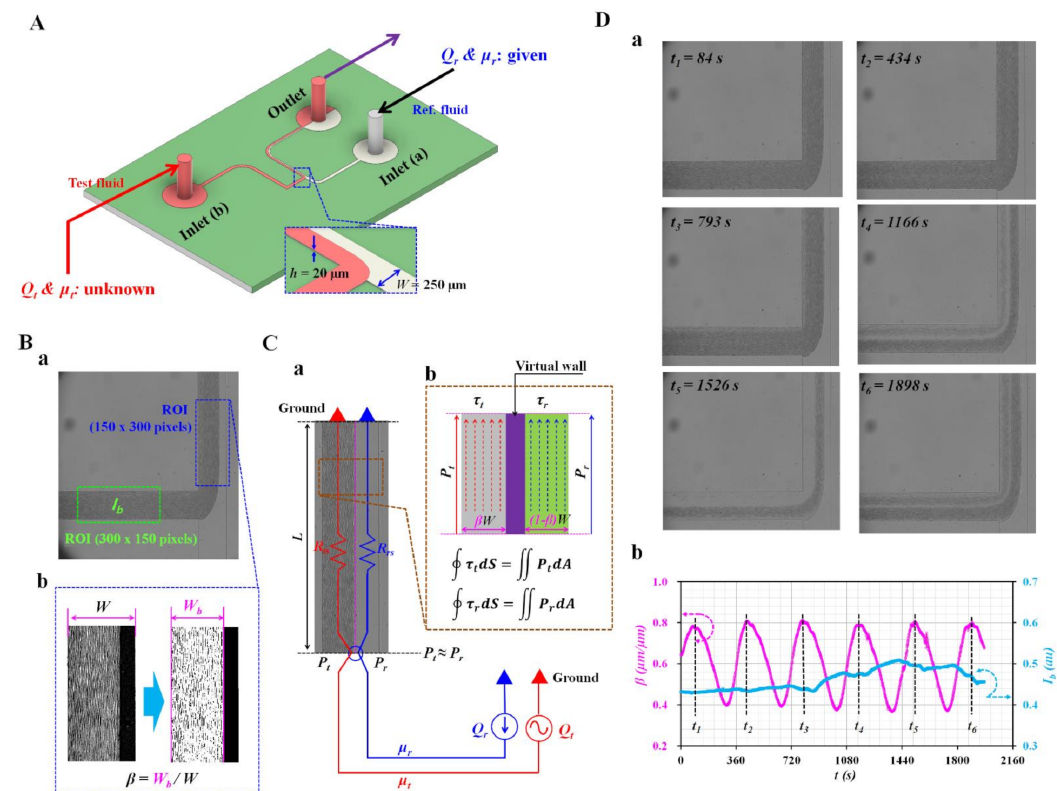
Figure 1. Proposed method for monitoring blood flows with several parameters (i.e., blood pressure, blood shear stress, blood pressure-driven work, and blood shear stress-driven work) using coflowing streams. ( A ) A microfluidic device for monitoring blood flows. The microfluidic device consists of two inlets (a, b), one outlet, guide channels for two fluids, and coflowing channels (width [ W ] = 250 µ m, and depth [ h ] = 20 µ m). Test fluid (i.e., flow rate [ Q t ] and viscosity [ µ t ]: unknown) was supplied into the inlet (a). Reference fluid (i.e., flow rate [ Q r ] and viscosity [ µ r ]: known) was injected into the inlet (b) with a syringe pump. ( B ) Quantification of image intensity of blood flow and interface in the coflowing channel. (a) Two regions of